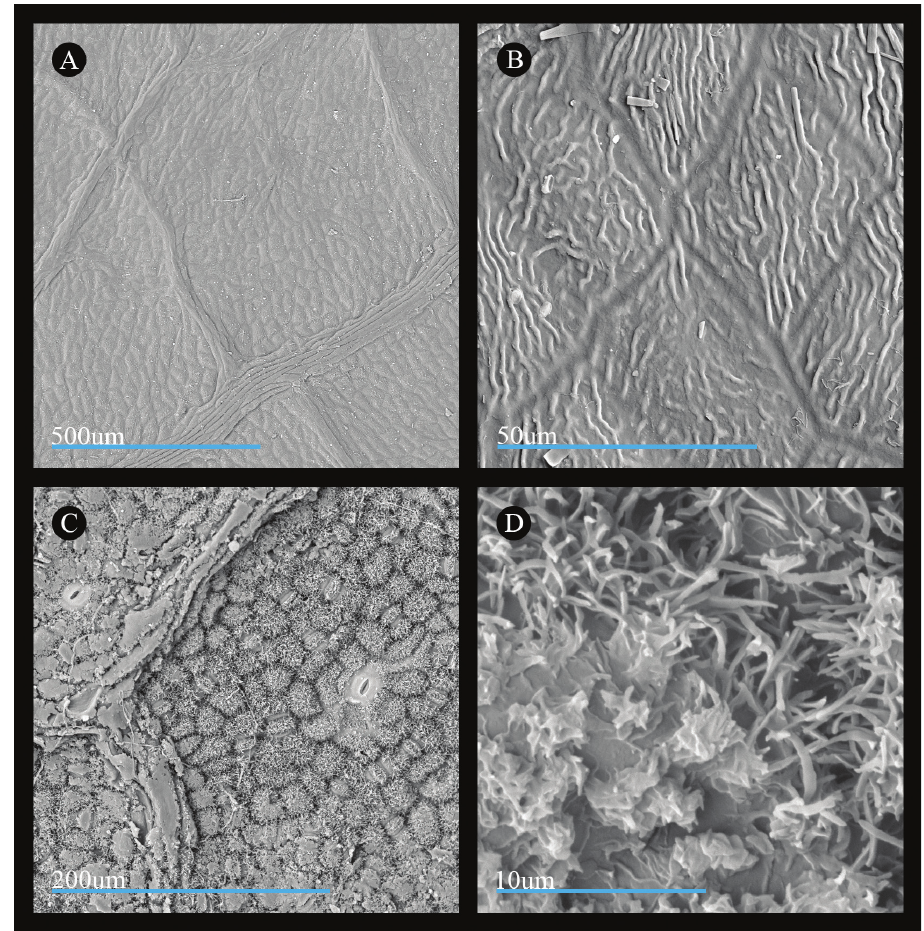
Figure 5. Micrographs of the leaf surfaces of Acer pycnanthum . A Adaxial surface showing cell shape and organization ( Wilson 6882 ) B Adaxial surface showing cuticle ( Collector unknown, s.n. ) C Abaxial surface showing cell shape and organization of cells and stomata ( Wilson 7729 ) D Abaxial surface show- ing cuticular wax ( Wilson 6882 ). All leaf materials are from specimens deposited at US, and parenthetical information in this legend refers to the collector name and